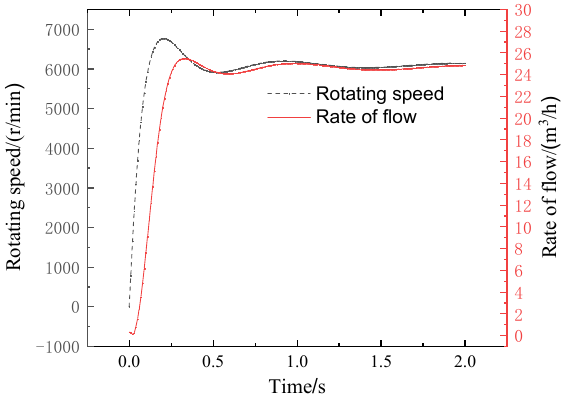
Figure 5. Speed and flow curve of centrifugal pump during startup.